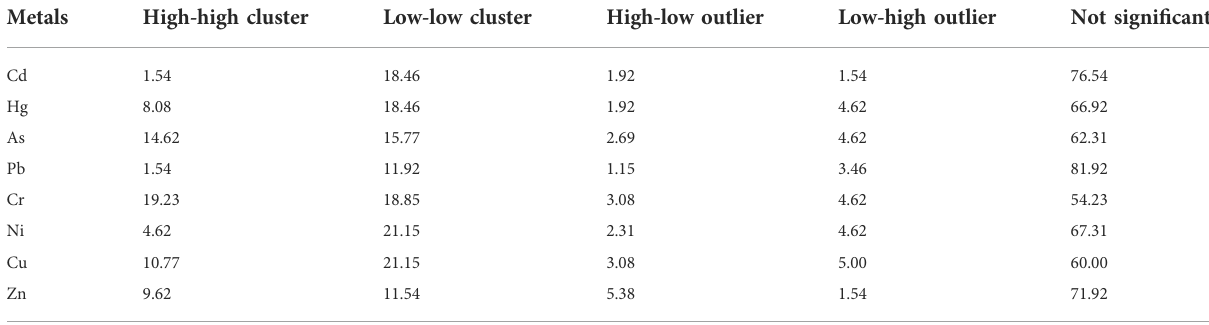
TABLE 4 Percentage of local spatial pattern types of heavy metals in rice